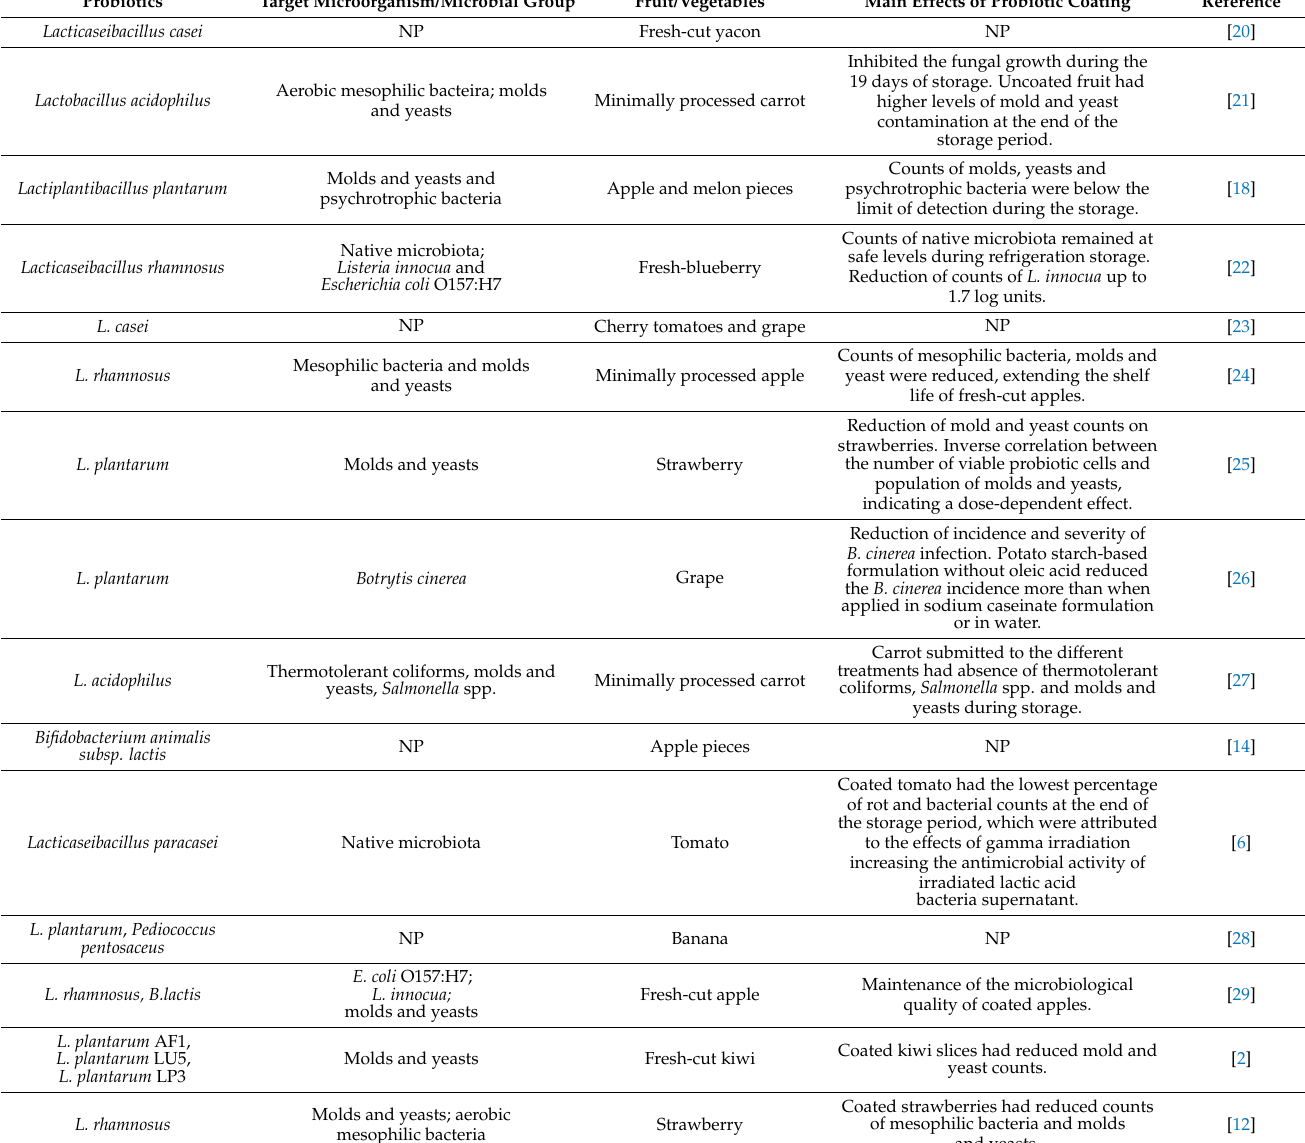
Table 3. Antimicrobial effects of probiotic-loaded edible films/coatings when applied to fresh and minimally processed fruit and